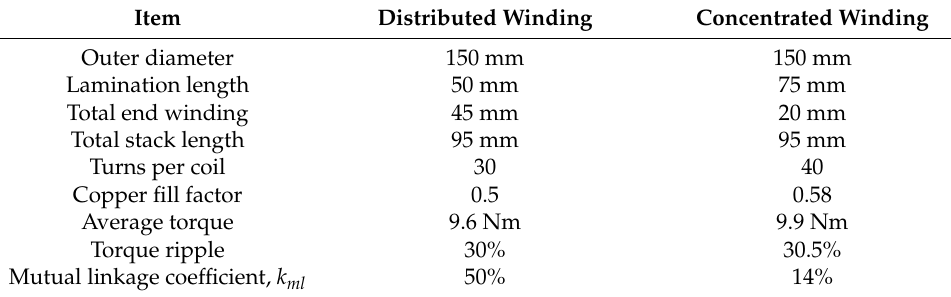
Table 7. Design Specifications of the 12/4